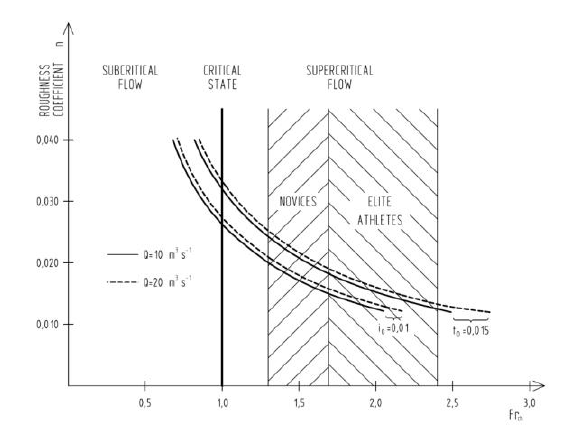
Figure 3. Relationship between friction factor and characteristic Froude number (artificial slalom